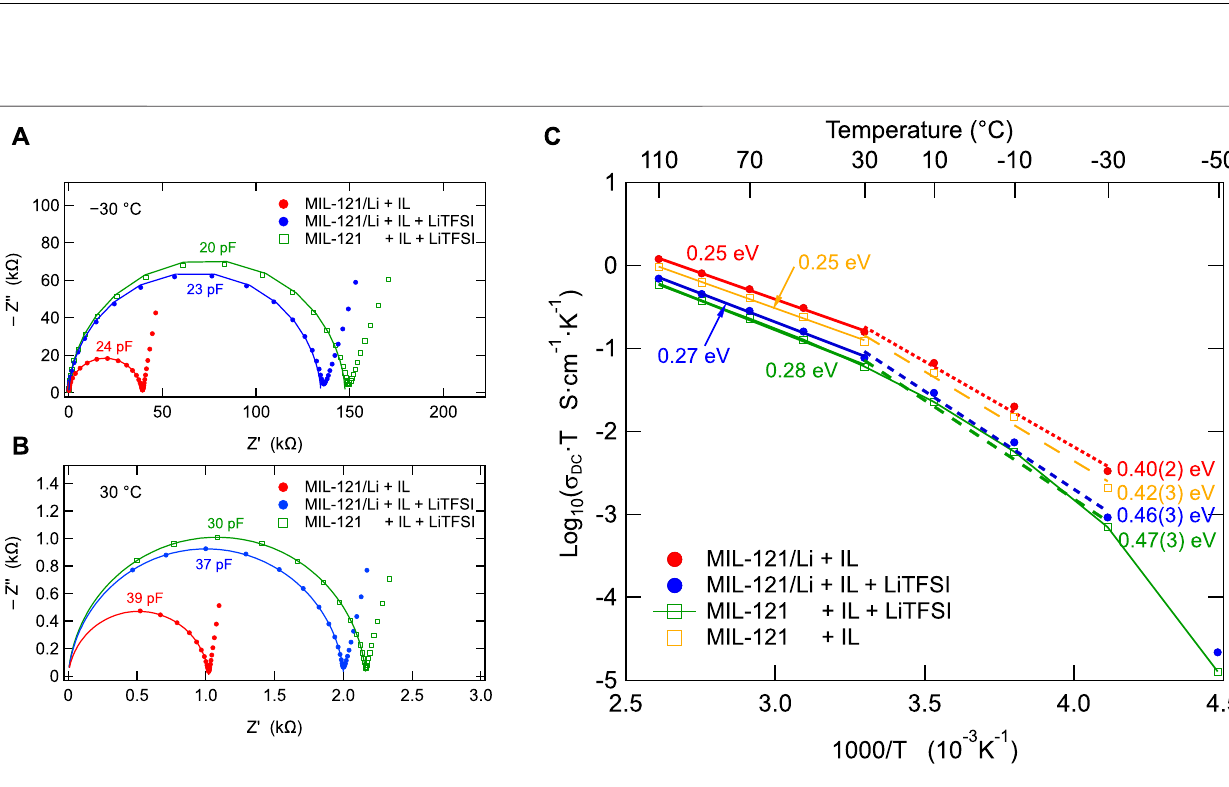
Frontiers in Energy Research |